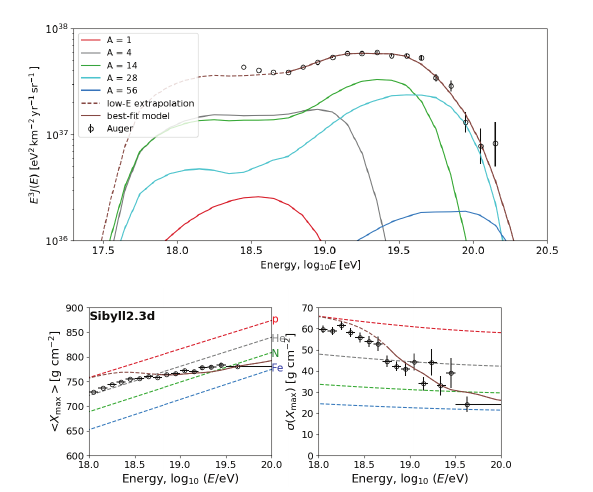
Figure 1. Top: Fluxes of nuclei with primary injected particles as labelled. Curves with di ff erent colours show the sum of the flux of primaries with a given mass number and all secondaries produced by the same nuclear species. The fit is performed only at energies above the ankle (10 18 . 7 eV). Experimental data are the flux measurements by the Pierre Auger Collaboration [6]. Bottom: black points are the average and standard deviation of the X max distribution at each energy, as measured by the Pierre Auger collaboration ; coloured lines are predicted by Sibyll2.3d [7] for various pure compositions (thin lines) and for the compo- sition predicted by our model at the best fit (thick brown line).